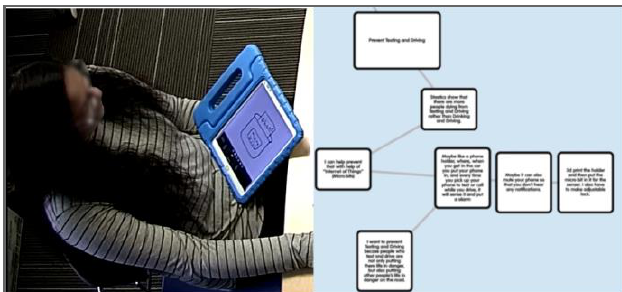
Figure 6. Amalya’s passion project